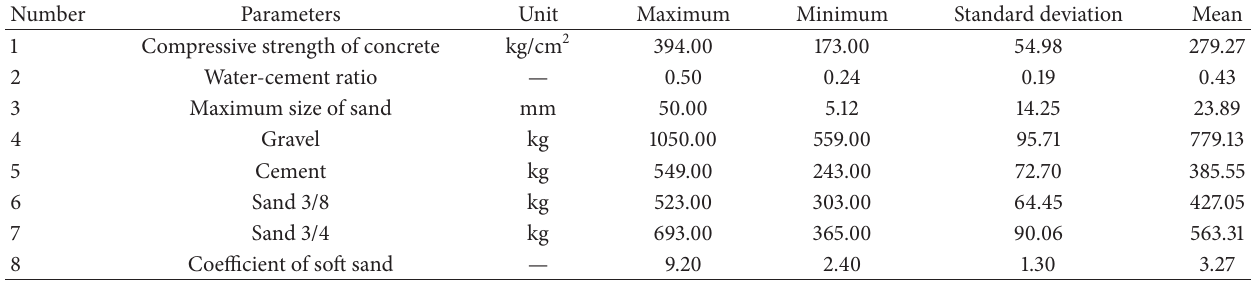
Table 1: Characteristics of cylindrical samples.